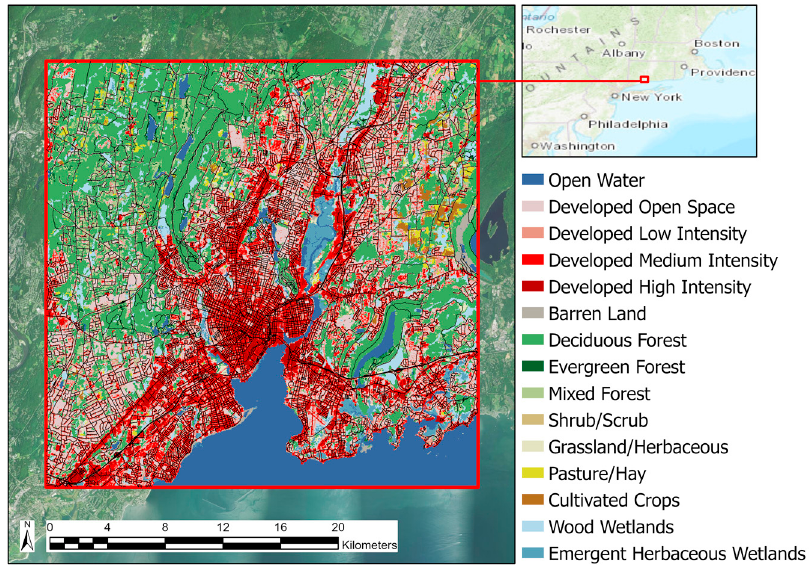
Figure 1. Land use types of New Haven County, Connecticut, United States. The red box indicates the study area. Black lines display the road network. The land use data is provided by National Land Cover Database (NLCD) of 2016 (https://www.mrlc.gov; accessed date: 1 October 2021). The background is a true-color aerial image in 2018 provided by National Agriculture Imagery Program (NAIP).